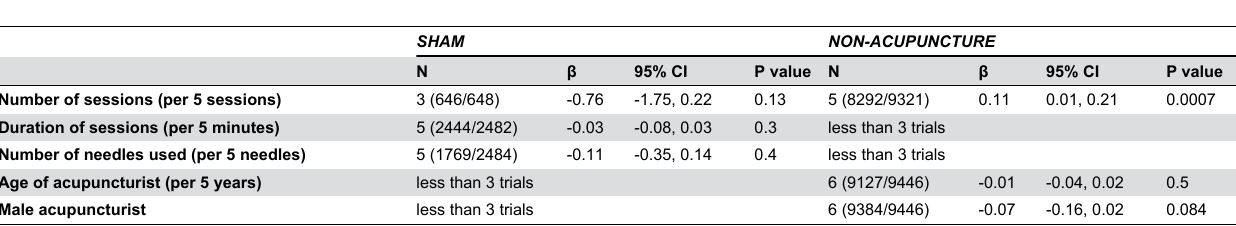
Table 5. Results of patient-level analysis of acupuncture